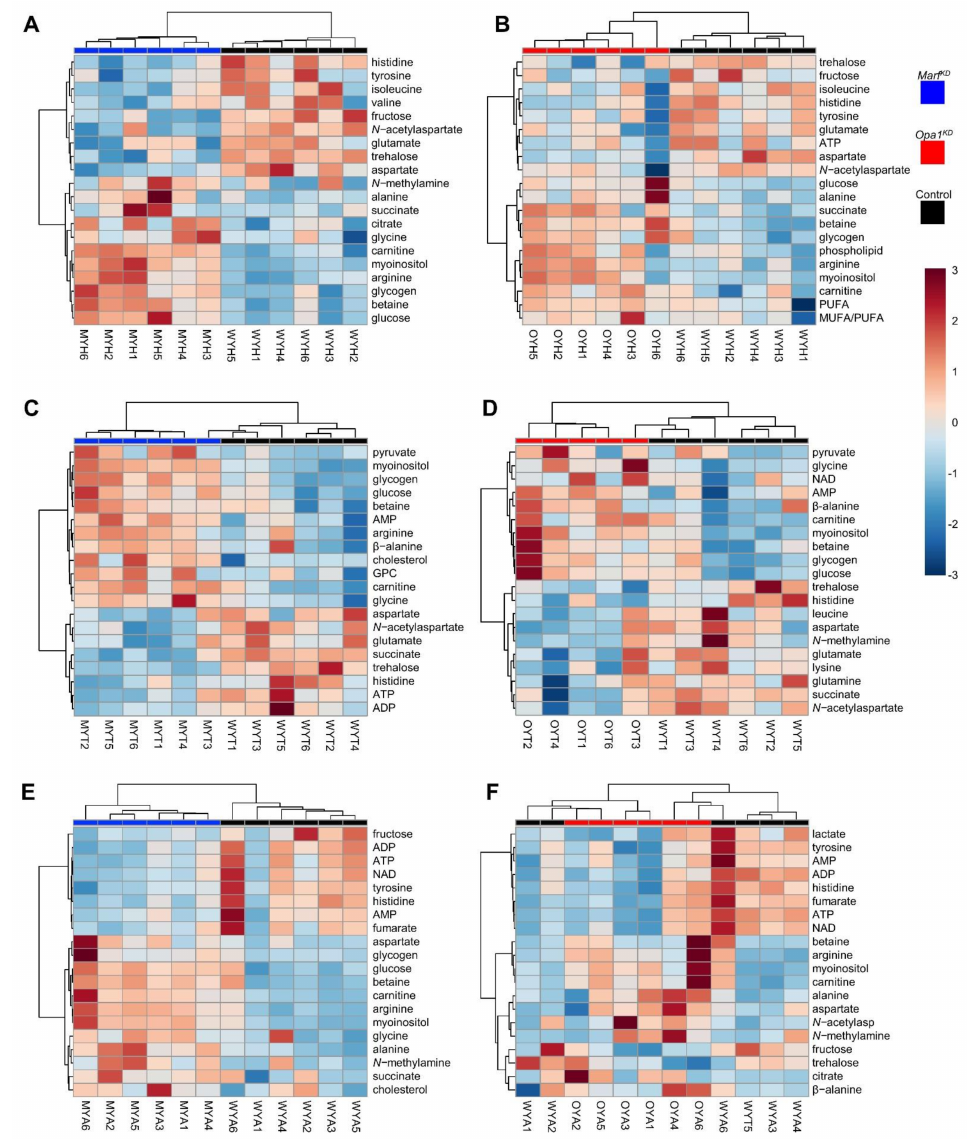
Figure 4. Heatmaps, 20 more relevant features at 30 days, ANOVA t -test. ( A ) Heads, control versus Marf KD . ( B ) Heads, control versus Opa1 KD . ( C ) Thorax, control versus Marf KD . ( D ) Thorax, control versus Opa1 KD . ( E ) Abdomen, control versus Marf KD . ( F ) Abdomen, control vs. Opa1 KD . Key to sample codes: C/M/0 means control/ Marf KD / Opa1 KD ; Y means young (30-day old); H/T/M means head/thorax/abdomen; The digit is the sample